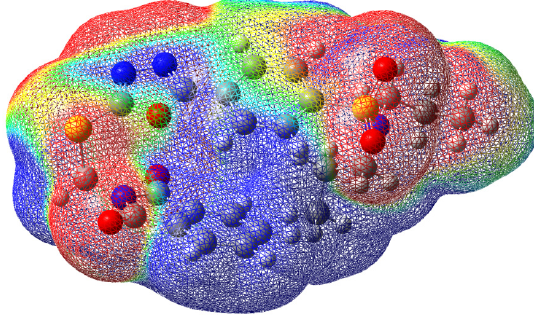
Figure 10. MEP map of the PESMP compound.